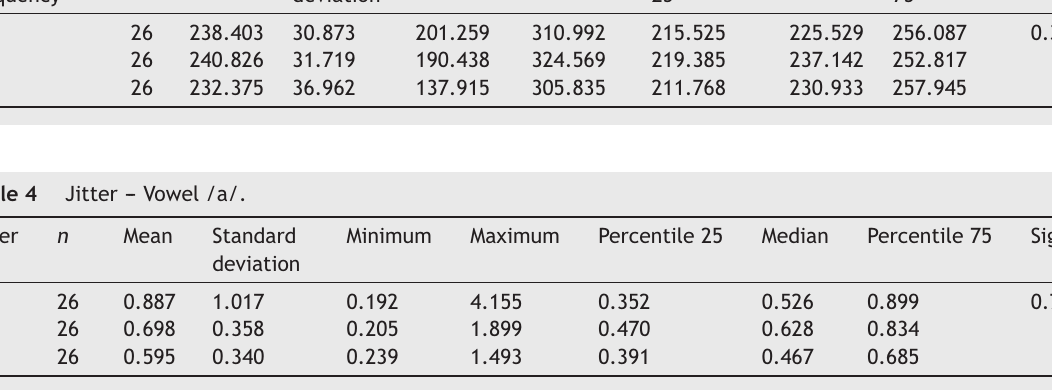
Fundamental frequency --- Vowel /a/. Fundamental